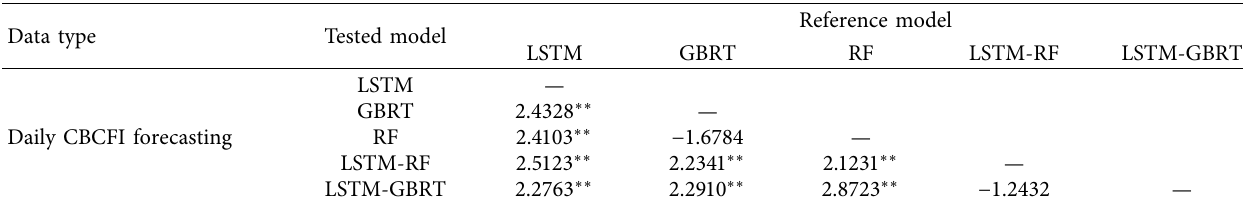
Figure 9: Actual CBCFI and forecasting results through LSTM-EL approaches and corresponding EL approaches for (a) daily, (b) weekly, and (c) monthly data. Table 7: DM test results for hybrid models and the